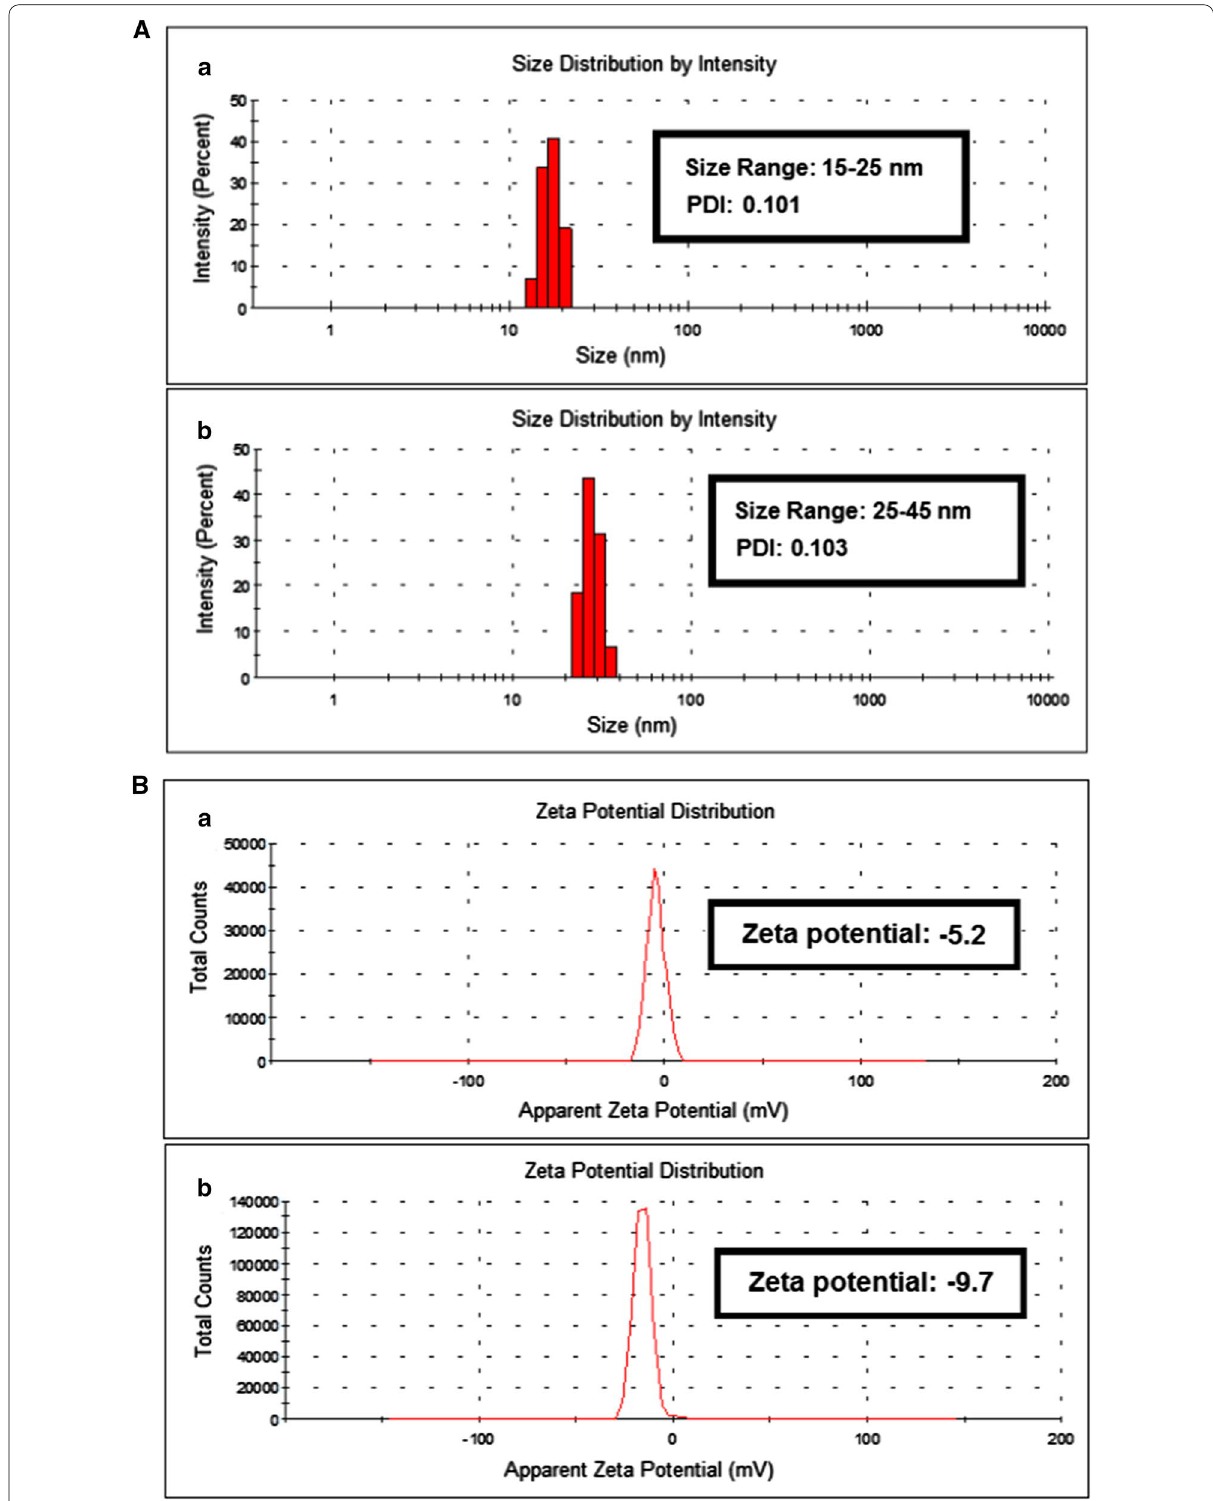
Fig. 2 Showing the average particle size distribution histogram and zeta potential of ZnO nanoparticle and the reducing/capping agent A depicts average particle size distribution a ZnO nanoparticles (ZnO NPs) and b beta-cyclodextrin capped ZnO NPs (ZnO-BCD NPs) and B showing zeta potential graph of a ZnO nanoparticles (ZnO NPs) and b beta-cyclodextrin capped ZnO NPs (ZnO-BCD